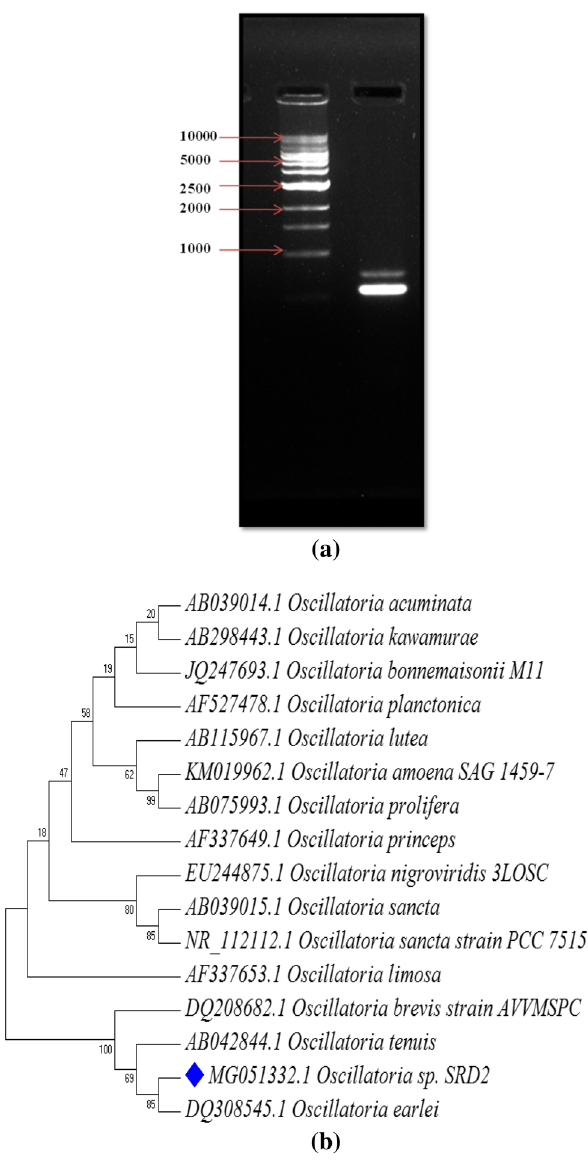
Fig. 2 a PCR amplified product of Oscillatoria sp. 16 s rRNA gene and b phylogenetic tree of the Oscillatoria sp.